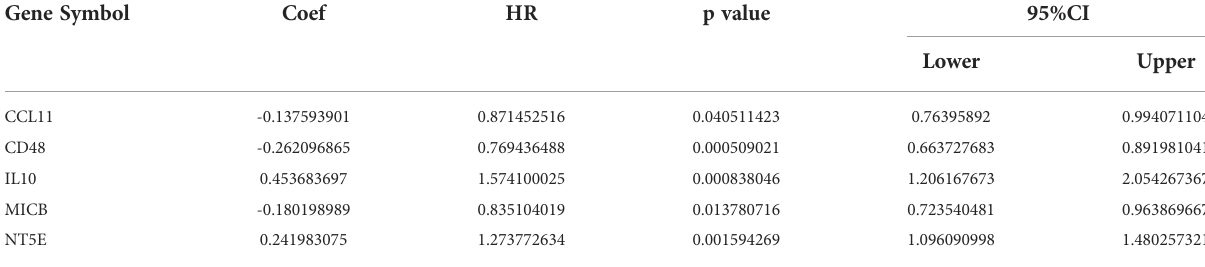
TABLE 1 Multivariate Cox regression for immune regulation genes.